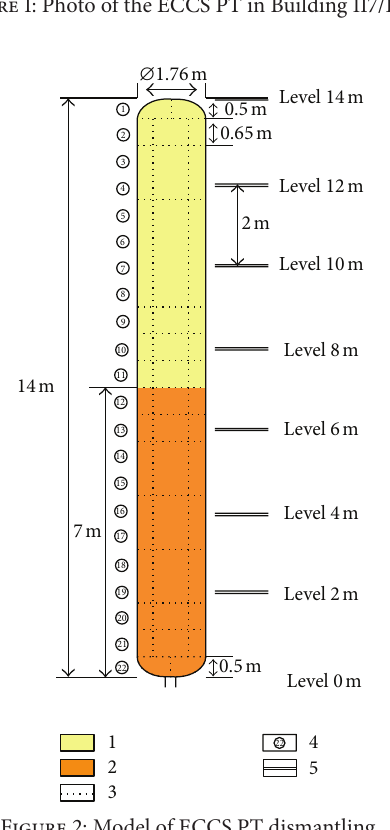
Figure 2: Model of ECCS PT